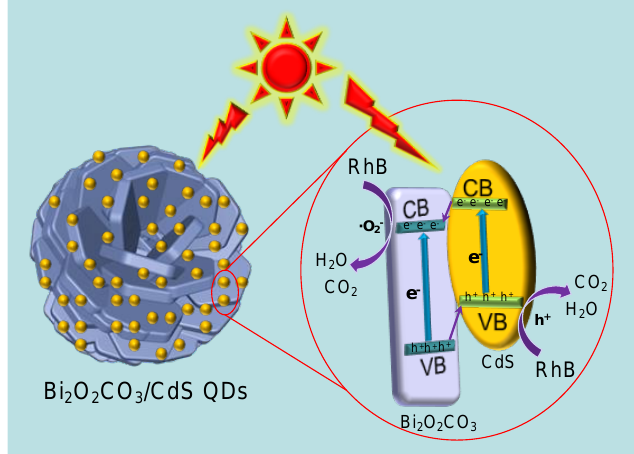
Figure 9. Schematic illustration of the enhanced photocatalytic degradation performance of Bi 2 O 2 CO 3 /CdS QDs-10.